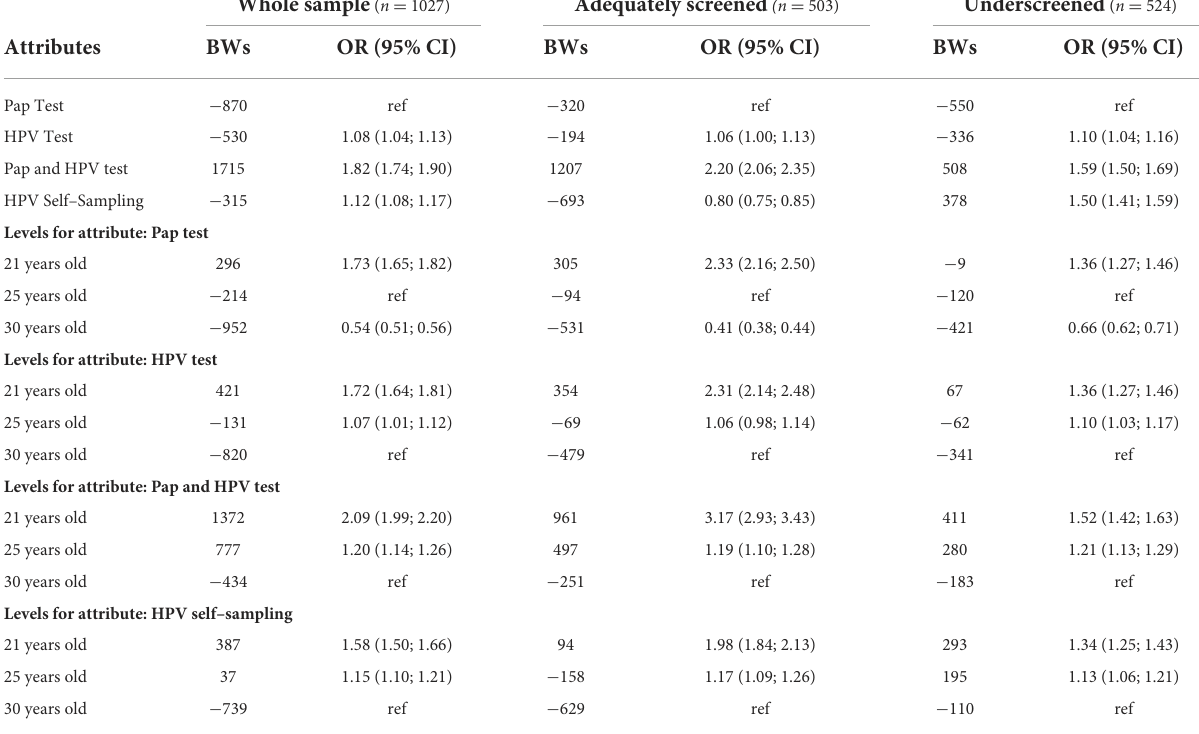
TABLE 3 Preferences for age of screening initiation (Domain B). Whole sample ( n = 1027) Adequately screened (n = 503) Underscreened ( n =